Question: Briefly state, in one sentence, what is plotted here.
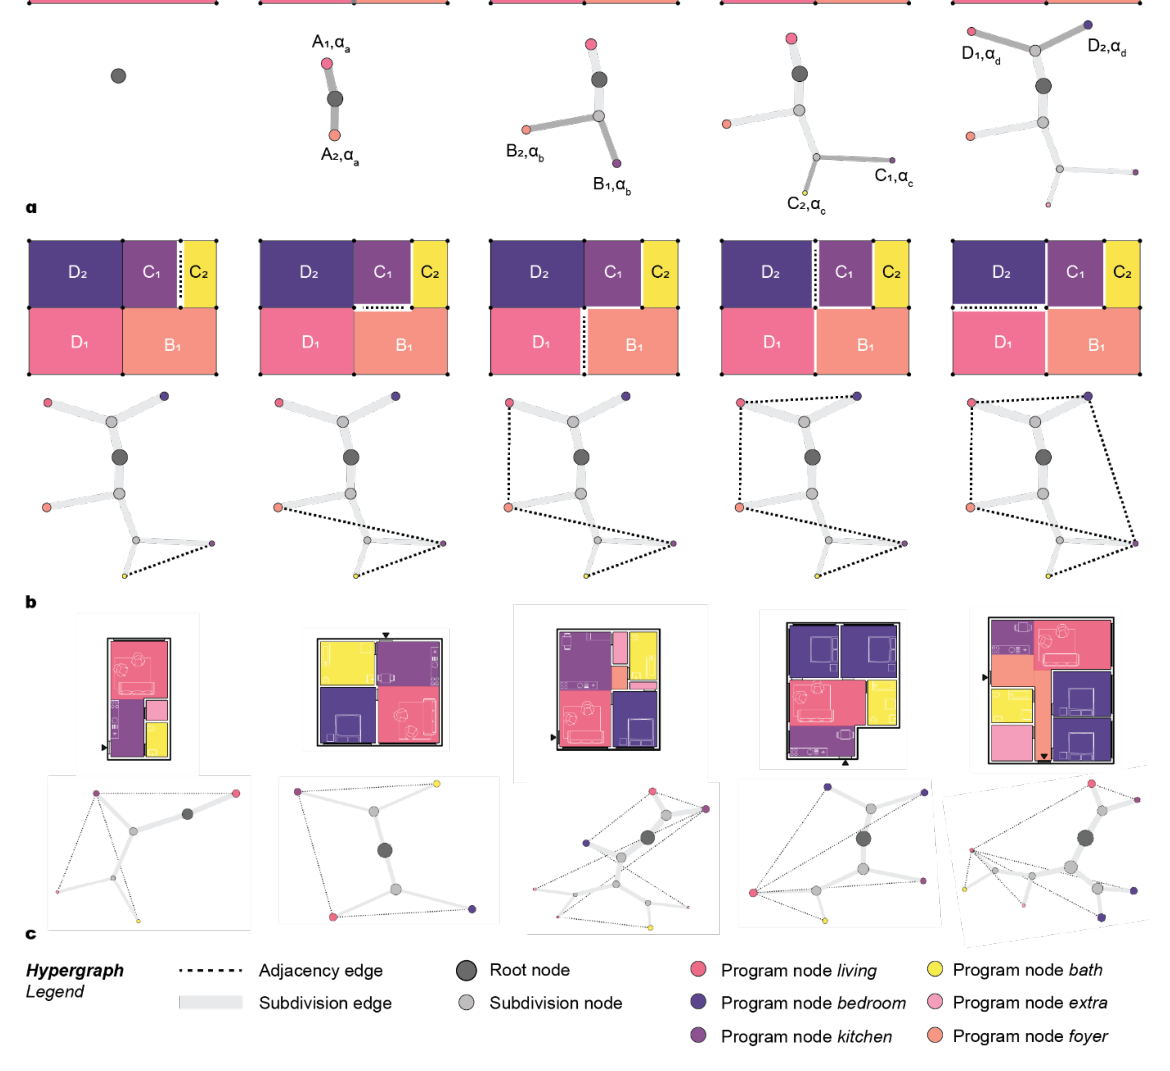
Answer: Step by step generation of the subdivision graph (a) from area O, represented by the grey point (graph root). It is  subsequently divided into area A1 and A2 with the angle αa, A2 is divided into B1 and B2 with angle α, B2 is divided into C1 and  C2 with angle angle αc and A1 divided into D1 and D2 with angle αd. The access between rooms is converted into a graph (b)  where edges connect the room nodes of the subdivision graph that connect (e.g. the rooms that are accessible between one  another). Different subdivisions therefore result in different hypergraphs (c).